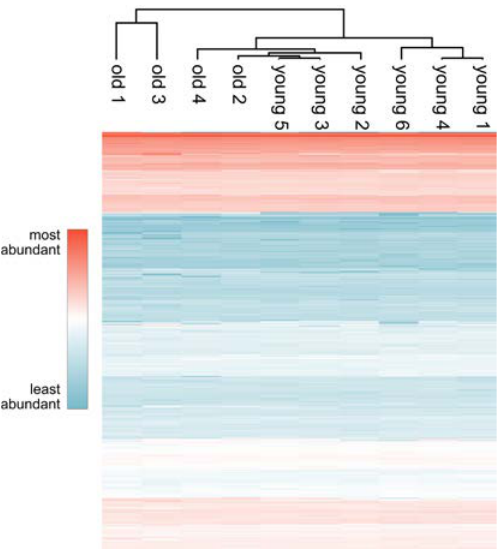
Figure A2. Unsupervised hierarchical clustering of old and young C. jacchus testicular proteome profiles.